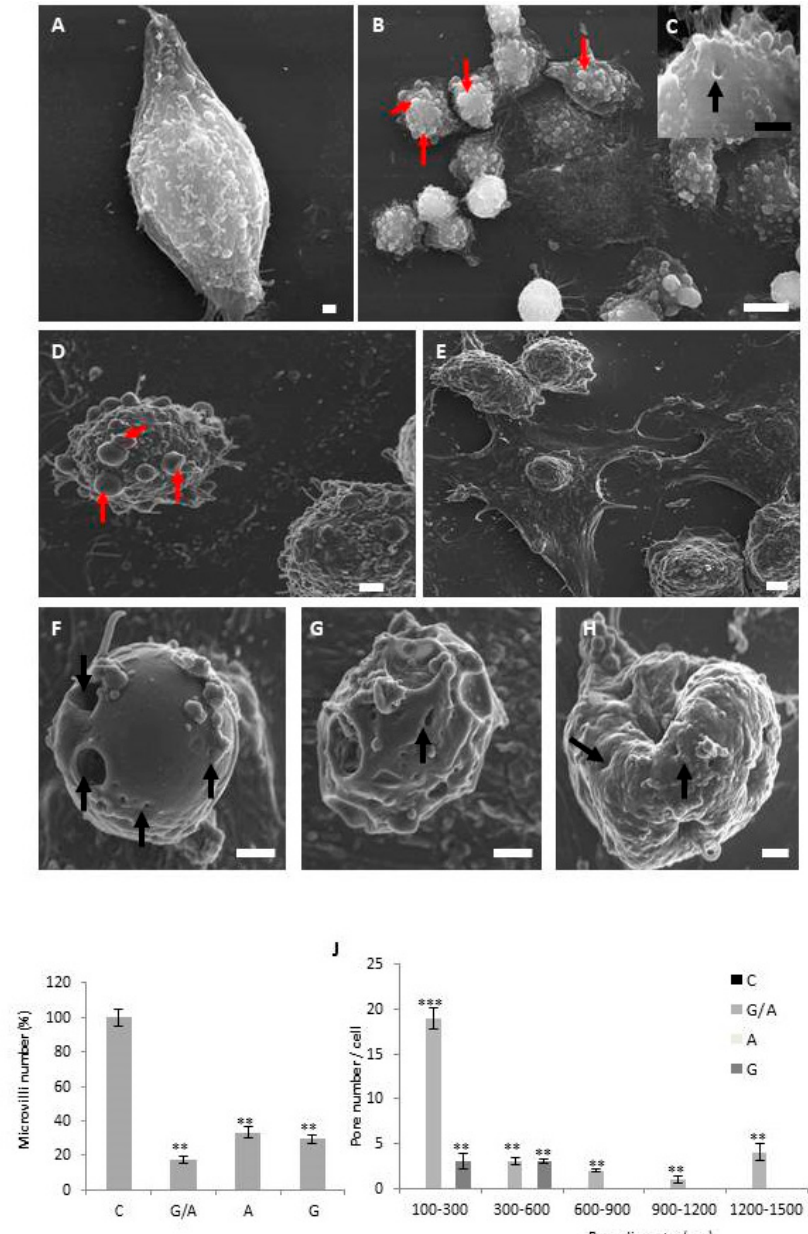
Figure 3. Scanning electron microscopic images of parental and transduced DLD-1 cells. DLD-1 cell line adhered to the culture surface with multiple filipodium ( A ). DLD1/Tet-On-gef cell line showed cells with several apoptotic bodies (red arrows) ( B ) and some cells have pores on their membrane surface ( C ). DLD1/Tet-On-apoptin cells showed signs of apoptosis with cytoplasmic membrane disruption, many apoptotic bodies, and clear signs of substrate detachment ( D ). DLD1/Tet-On-gef-apoptin cells, like the others, produced dead cells without filipodium and abundant apoptotic cells with the surface covered with apoptotic bodies ( E ). The most curious thing is that many more cells appeared with the surface full of pores of different sizes ( F – H ). Red arrows signal apoptotic bodies and black arrows pores (Scale bar A, C, D, F, G, H = 1 µ m; Scale bar B = 10 µ m; Scale bar E = 2 µ m). Quantification of filipodium number ( I ). Pore number ( J ). The height of each bar represents the number of pores with diameters in the interval between its lower and upper bounds on the x-axis. Pore diameters between 100–1500 nm can be observed in DLD21/Tet-On- gef-apoptin cells. Quantifications were measured from the SEM images (5 random photos) from three independent sample preparations. The data is represented as mean ± S:D (** p < 0.01 vs. control and *** p < 0.001 vs.